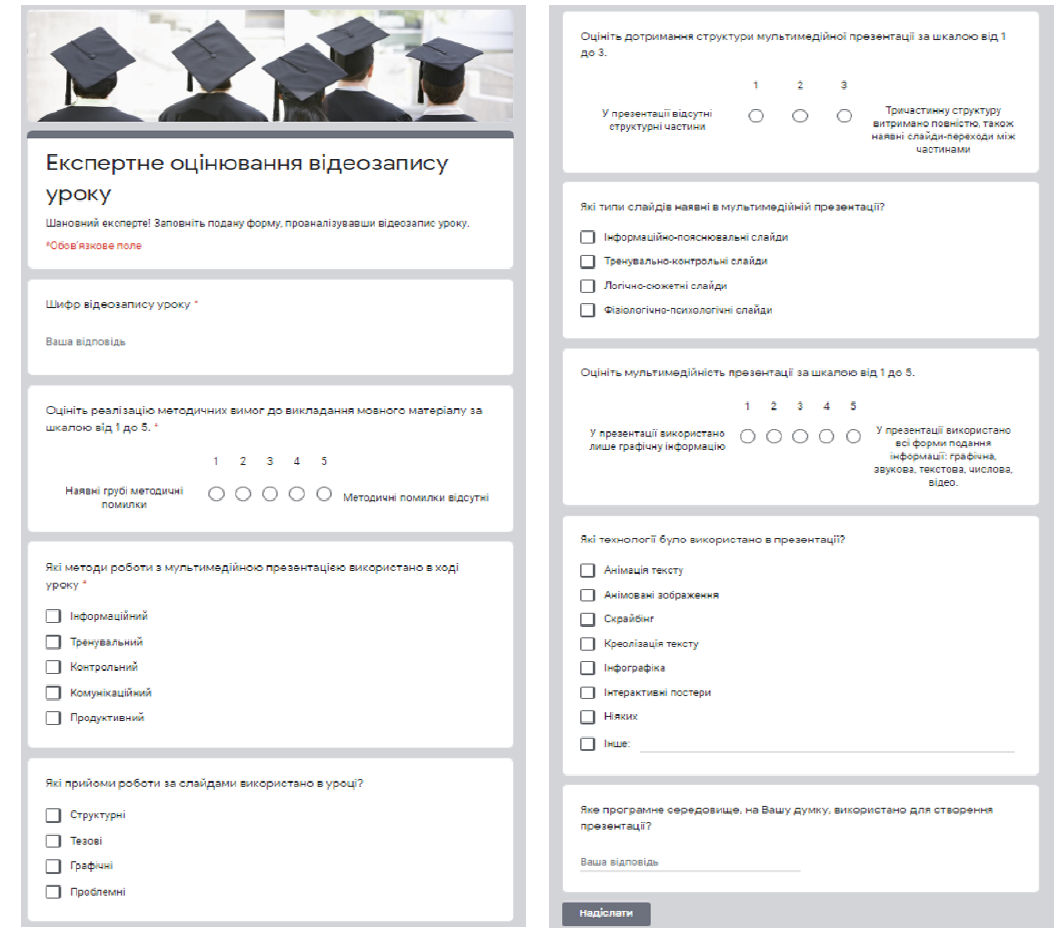
Figure 1: The expert evaluation